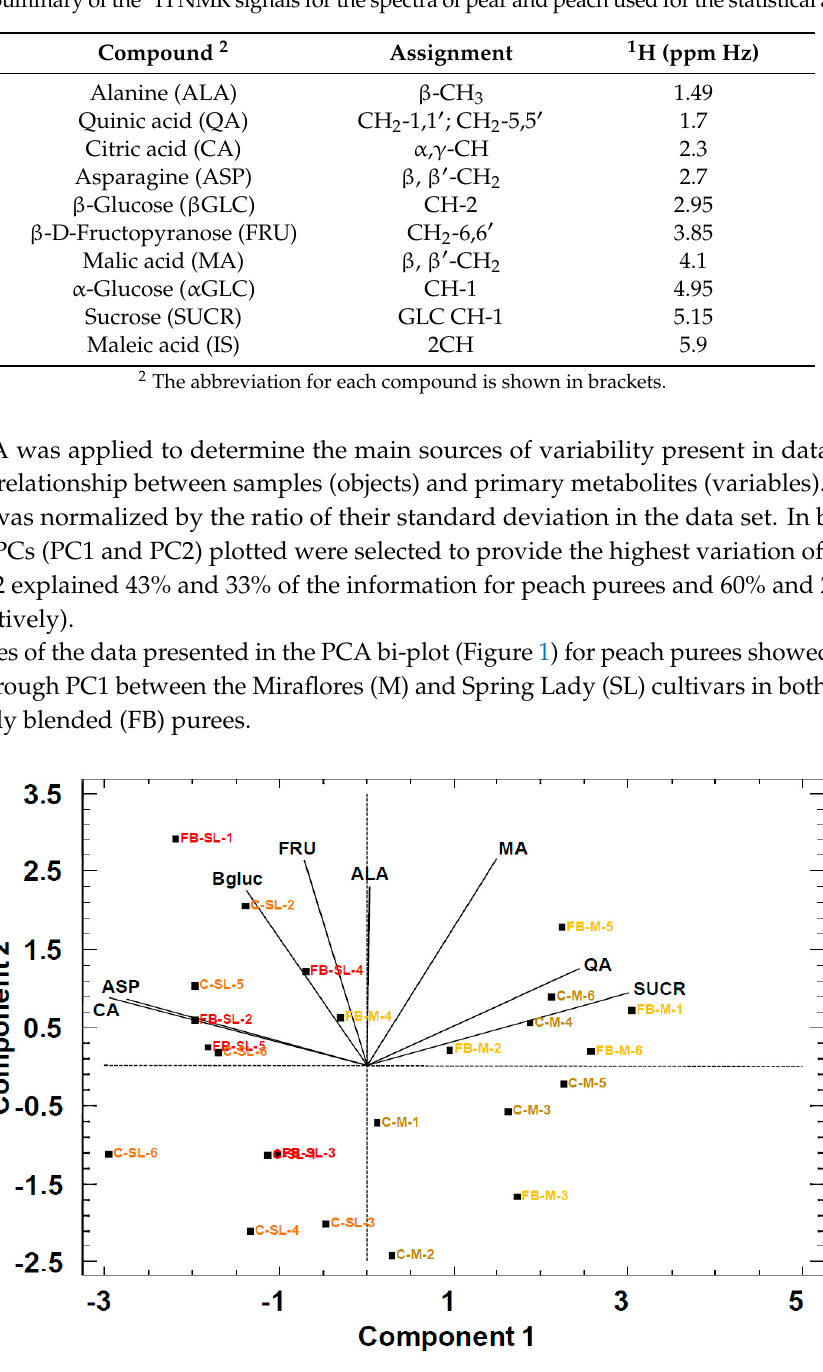
Figure 1. Principal Component Analysis (PCA) bi-plot of peach purees with primary metabolites as statistical variables. FB: Freshly blended, C: Commercial, SL: Spring Lady cultivar, and M: Miraflores cultivar. Ending number is the batch number. PC1: 43%, PC2: 33%.